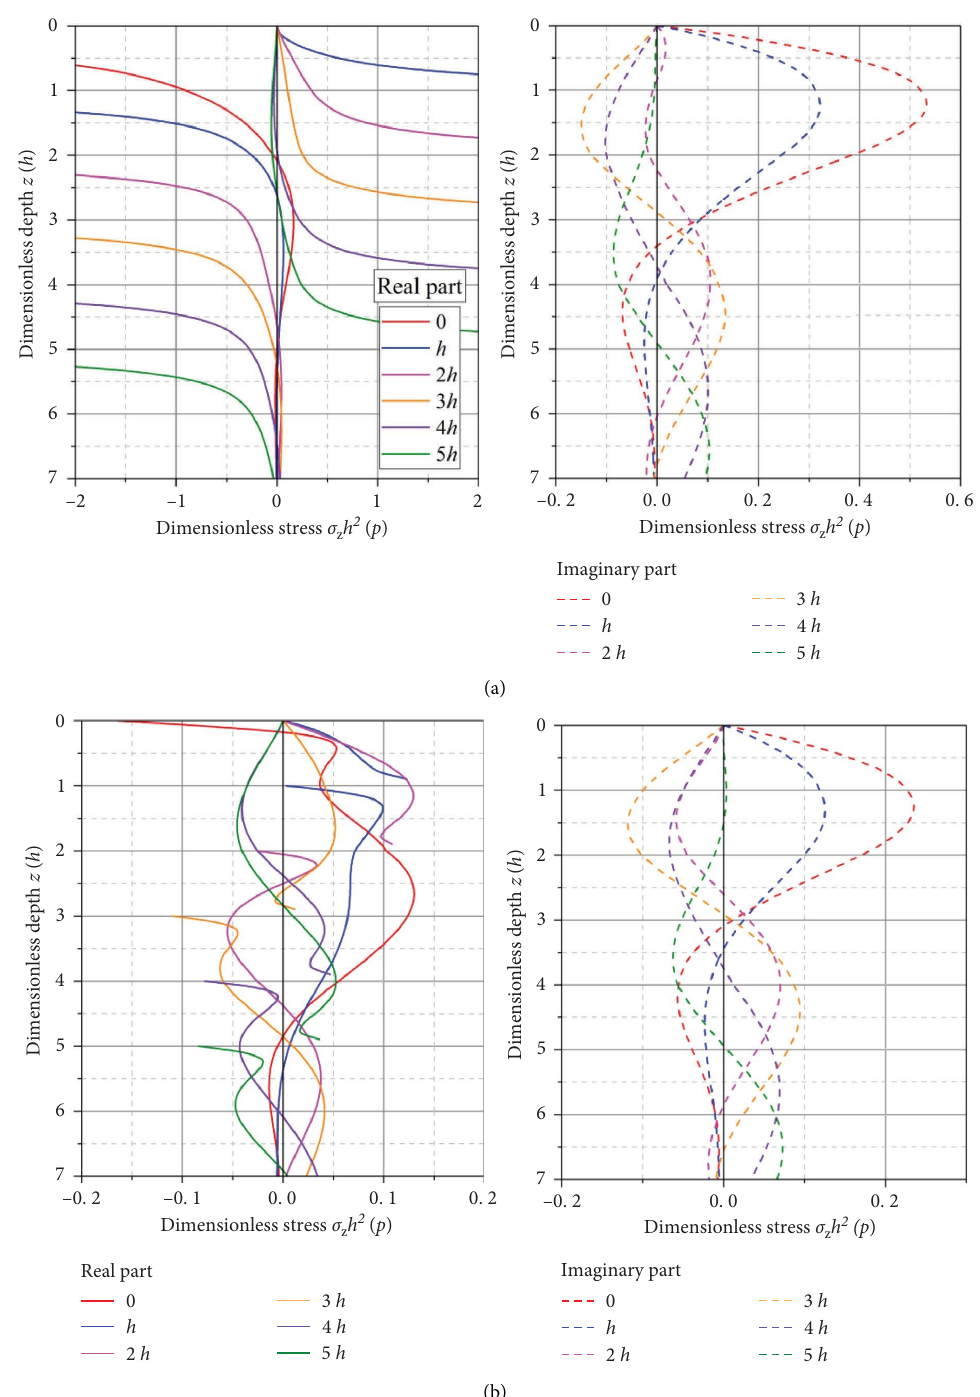
Figure 12: Te real and imaginary parts of the vertical stress at (a) r � 0 and (b) r � h versus the dimensionless depth at a fxed dimensionless frequency of two ( ω 0 �